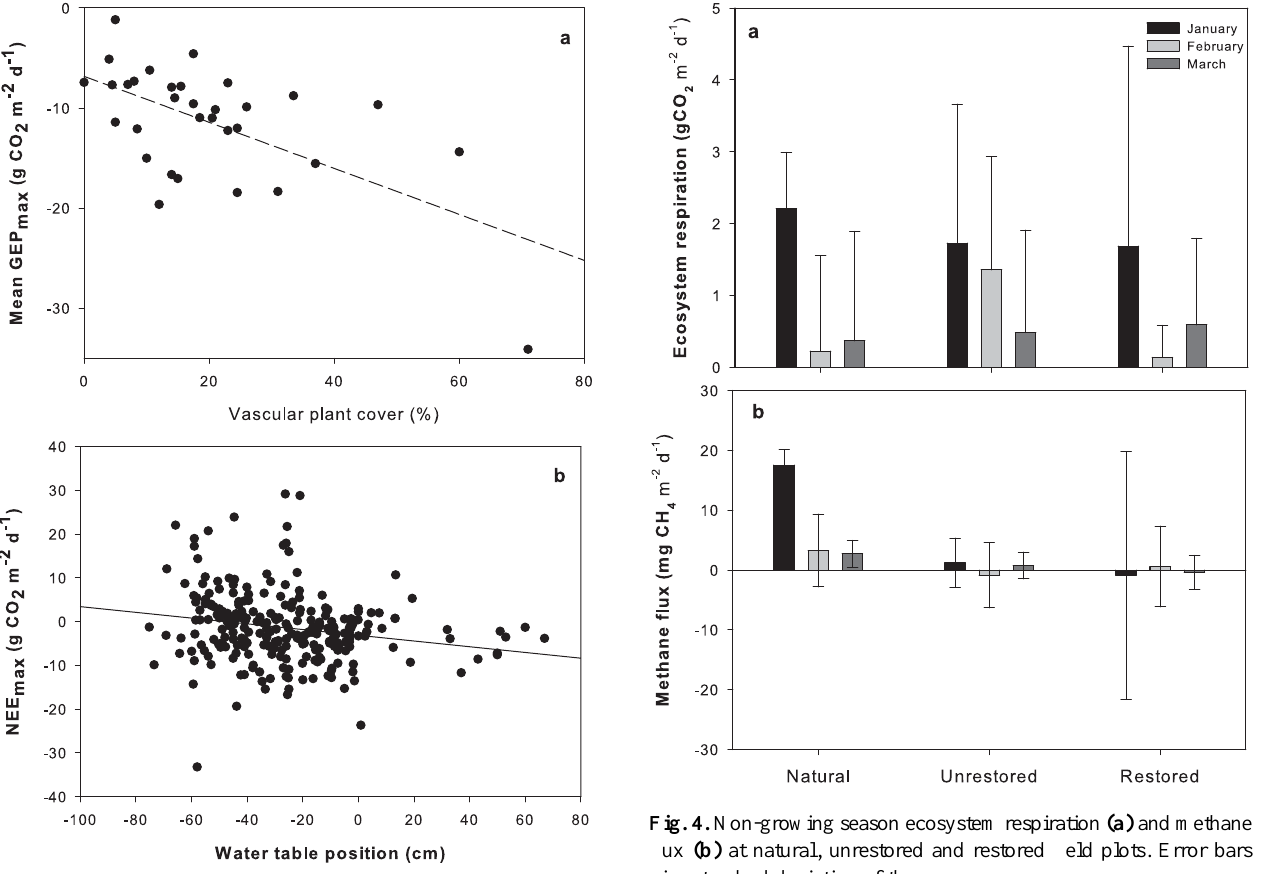
Fig. 3. (a) Regression between mean growing season gross ecosys- tem photosynthesis when photon flux density of photosynthetically active radiation was greater than 1000µmolm − 2 s − 1 (GEP max ) and vascular plant cover in July (GEP max =− 0.23 (vascular cover) – 6.8415; n = 32, R 2 = 0 . 37, p < 0.001). (b) Regression between net ecosystem exchange when photon flux density of photosynthetically active radiation was greater than 1000µmolm − 2 s − 1 (NEE max ) and the water table position (NEE =− 0.065 (water table) – 3.13; n = 261, R 2 = 0 . 04, p = 0.001). Negative values indicate uptake of CO 2 by the ecosystem and water table position below the soil sur- face, respectively.